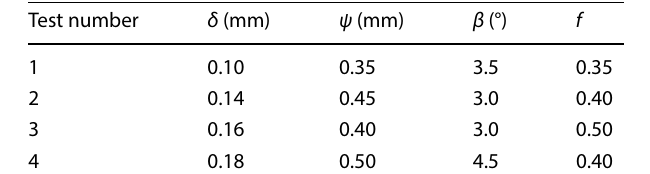
Table 1 The spinning process parameters